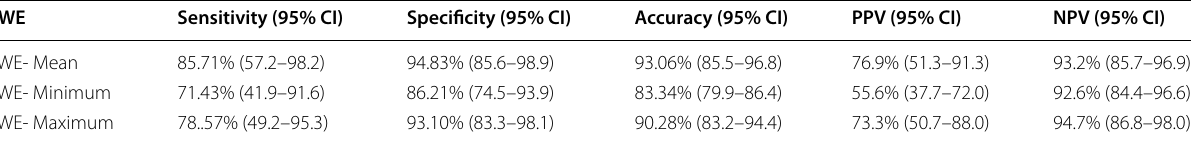
PPV (positive predictive value). NPV (negative predictive